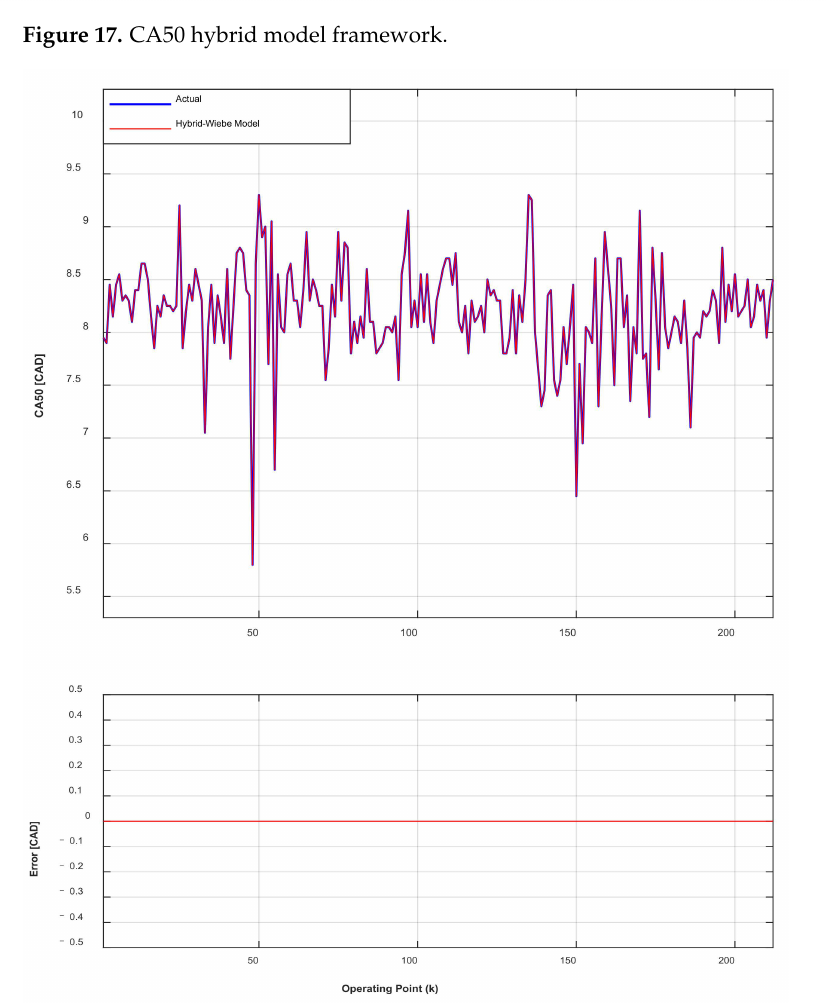
Figure 18. Comparison of the hybridized CA50 Wiebe model to the actual